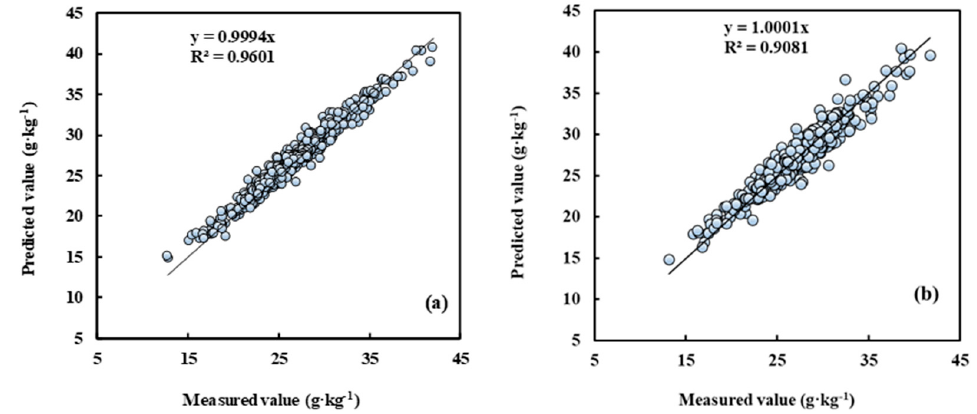
Figure 4. Measured vs. predicted N concentration for training and test by the AdaBoost.RT-BP model. Note: ( a ) is the training set, n = 856; ( b ) is the test set, n = 429.